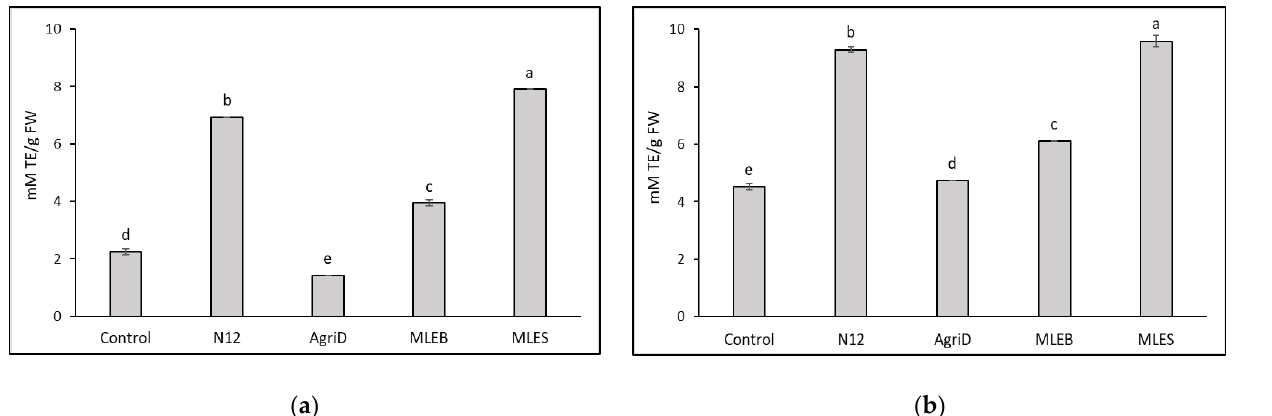
Figure 4. Effect of biostimulant application on lipophilic (DPPH) ( a ) and hydrophilic (ABTS) ( b ) antioxidant activity in lettuce leaves. TE = Trolox Equivalents. Different letters indicate significant differences according to Fisher ’s test ( p ≤ 0.05).